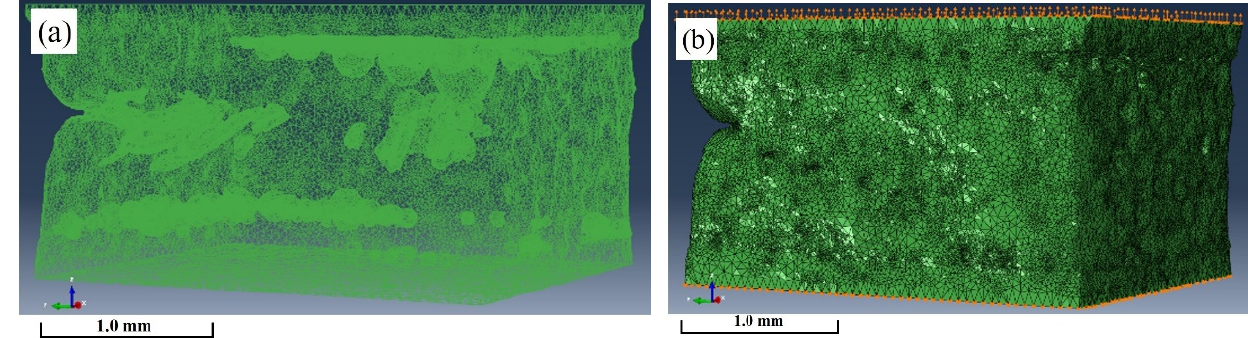
Figure 4. ( a ) Three-dimensional FE mesh model considering real internal defects; ( b ) boundary con- ditions and displacement loading of FE model. conditions and displacement loading of FE